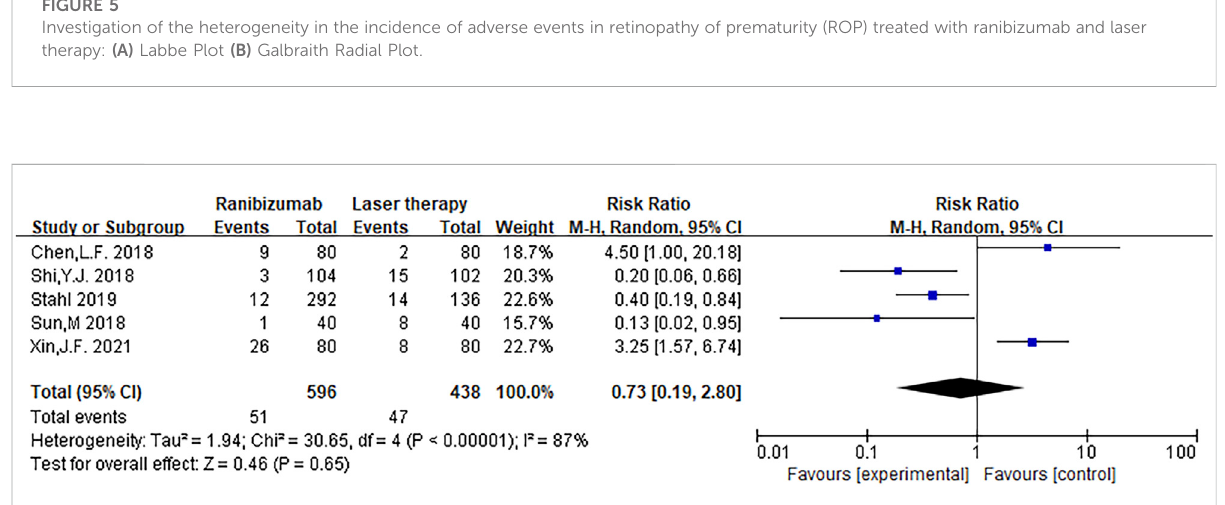
FIGURE 6 Forest plot: ranibizumab injection of retinopathy of prematurity (ROP) incidence of adverse events compared to laser treatment.